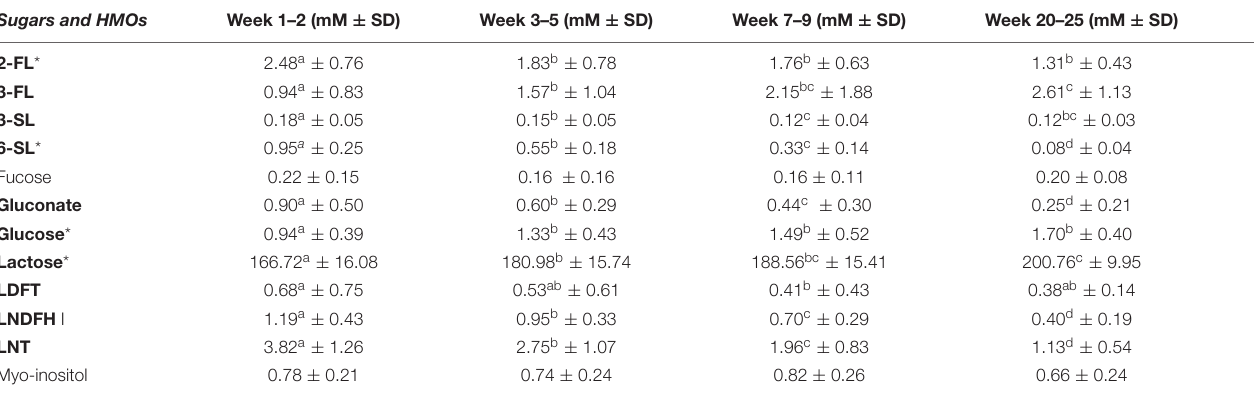
TABLE 2 | Mean levels (in mM ± standard deviation) of sugars and human milk oligosaccharides in human milk from term deliveries sampled weeks 1–2, 3–5, 7–9, and 20–25 postpartum. Sugars and HMOs